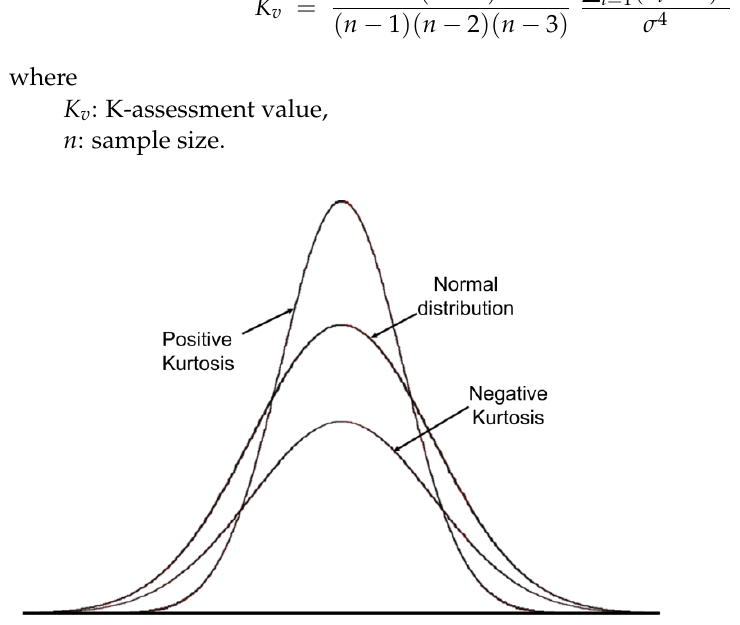
Figure 4. Kurtosis